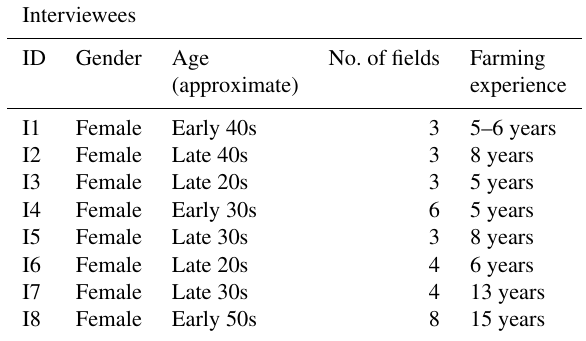
Table 1. List of interview participants, including approximate age, number of fields (size between 0.1 and 1.5acre – 0.04 and 0.6ha), and farming experience in